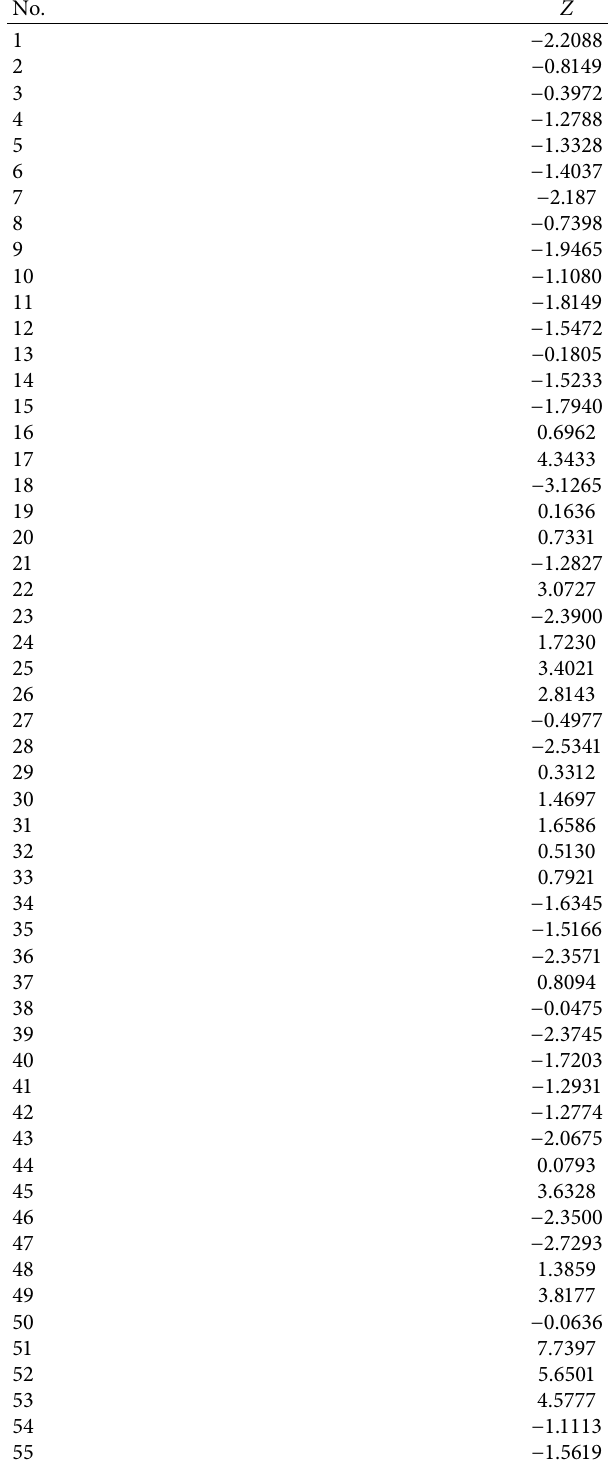
Table 6: Comprehensive evaluation of 55 batches of commercial